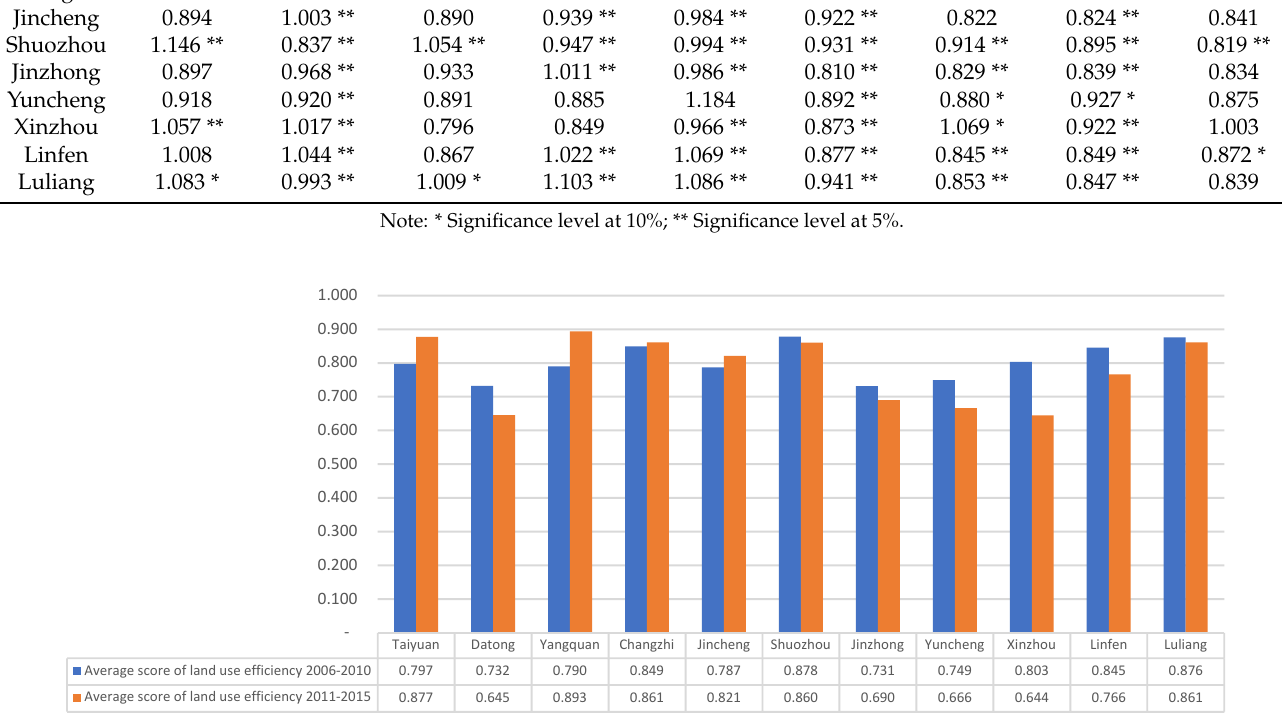
Figure 4. The overall (average) land use efficiency score trend for the total of studied cities in Shanxi Province from 2006– 2015.